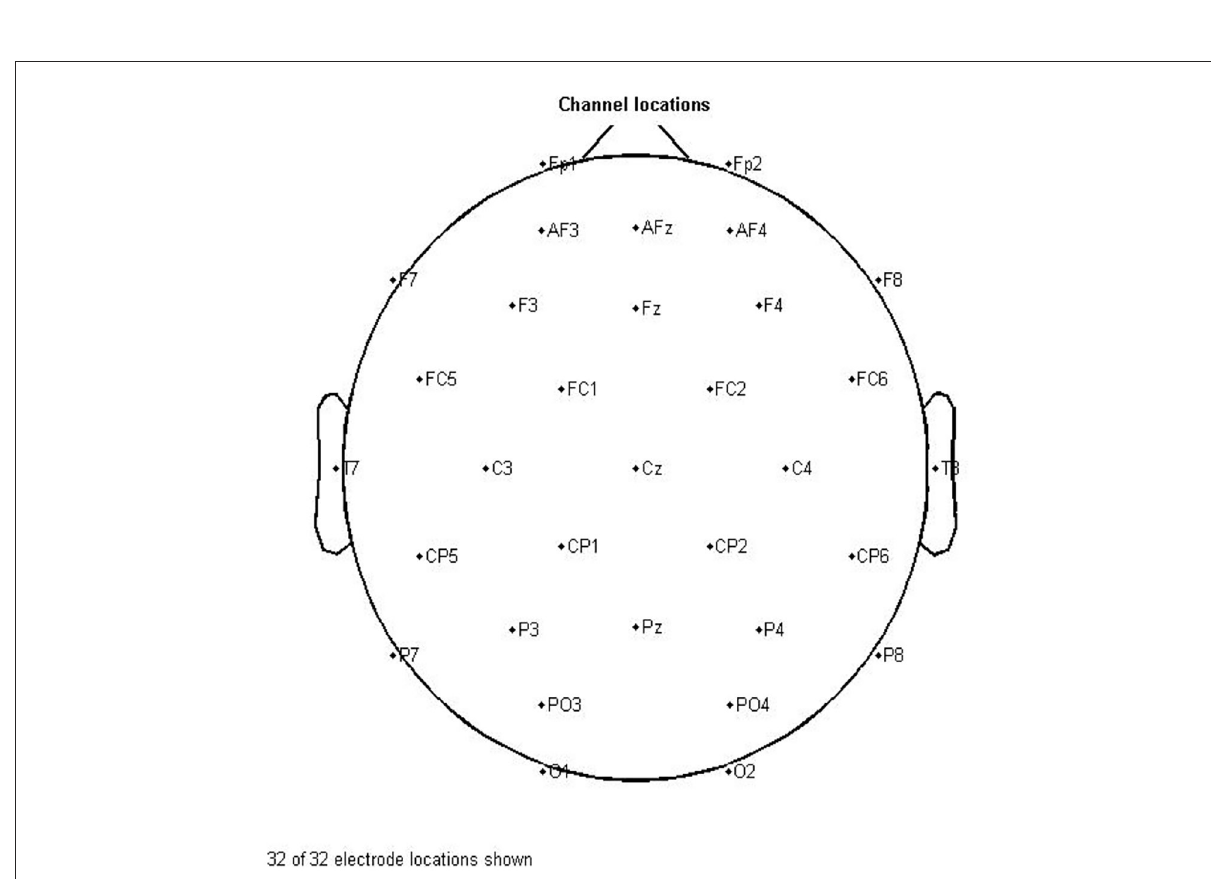
FIGURE1 Channel locations for 32